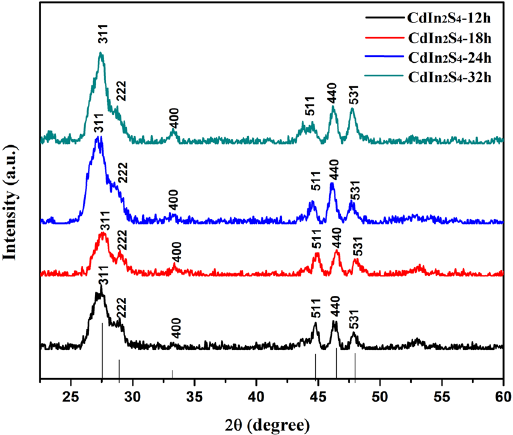
Figure 3. XRD patterns of CdIn 2 S 4 photocatalysts prepared at different times.